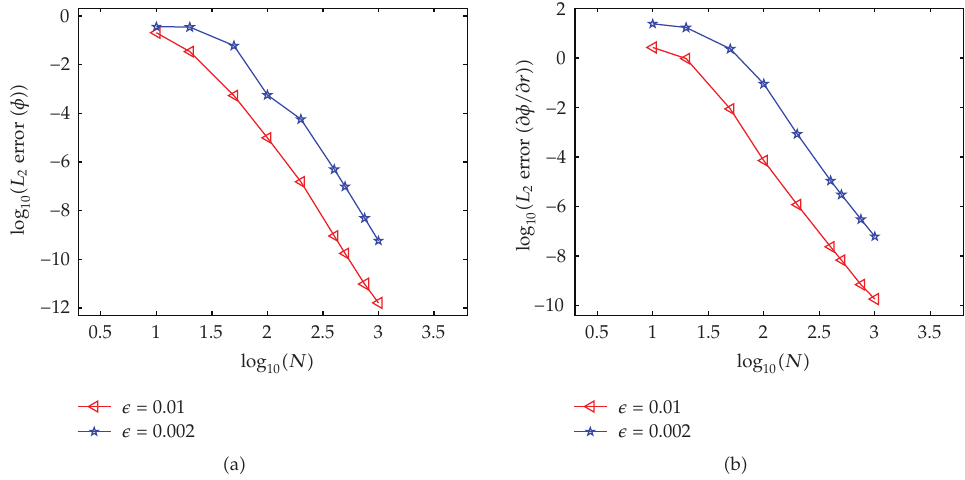
Figure 3: Comparisons of convergence rates of the sixth-order compact schemes for problem 1 at di ff erent values of (cid:5) : solution error φ (cid:6) a (cid:7) ; derivative error ∂φ/∂r (cid:6) b (cid:7) .